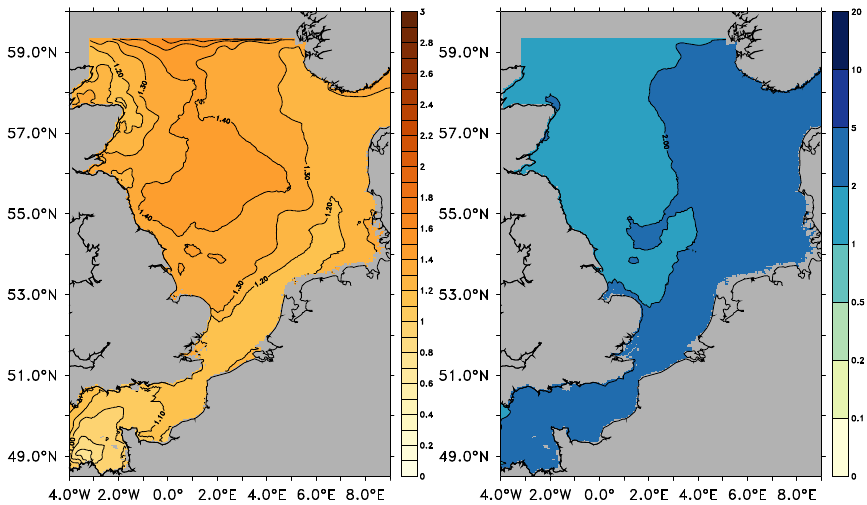
Figure 7. Ensemble dispersion in SST ( ◦ C) for the RCP8.5 ensemble during period P2 ( left ). The ensemble dispersion was calculated as the standard deviation among the ensemble members. Signal-to-noise ratio in SST for the RCP8.5 ensemble during period P2 ( right ). The signal-to-noise ratio was calculated as the ratio between the ensemble mean change and the ensemble dispersion (standard